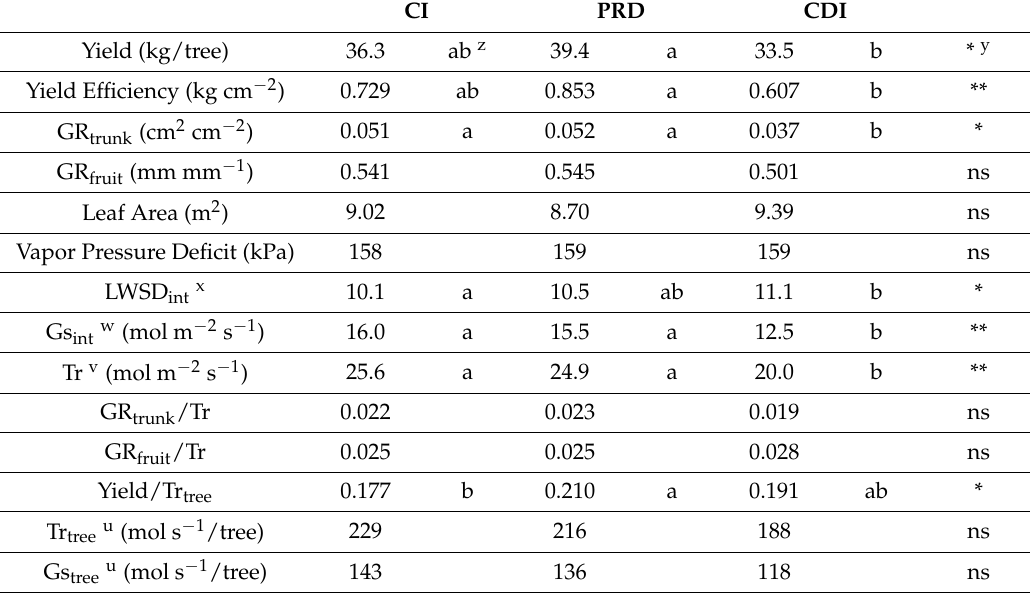
GR fruit /Tr 0.025 Yield/Tr tree Tr tree u (mol s − 1 /tree) Gs tree u (mol s − 1 /tree) z Mean separation within rows by Tukey’s multiple comparison test at P < 0.05 y Level of statistical significance for irrigation factor from analysis of variance: ns, P > 0.05; *, P < 0.05; **, P < 0.01; ***, P < 0.001. x LWSD int is leaf water saturation deficit integrated across the irrigation period. w Gs int is stomatal conductance integrated across the irrigation period. v Tr is transpiration integrated across the irrigation period. u Seasonal integrals of total conductance (GS tree ) and transpiration (Tr tree ) per